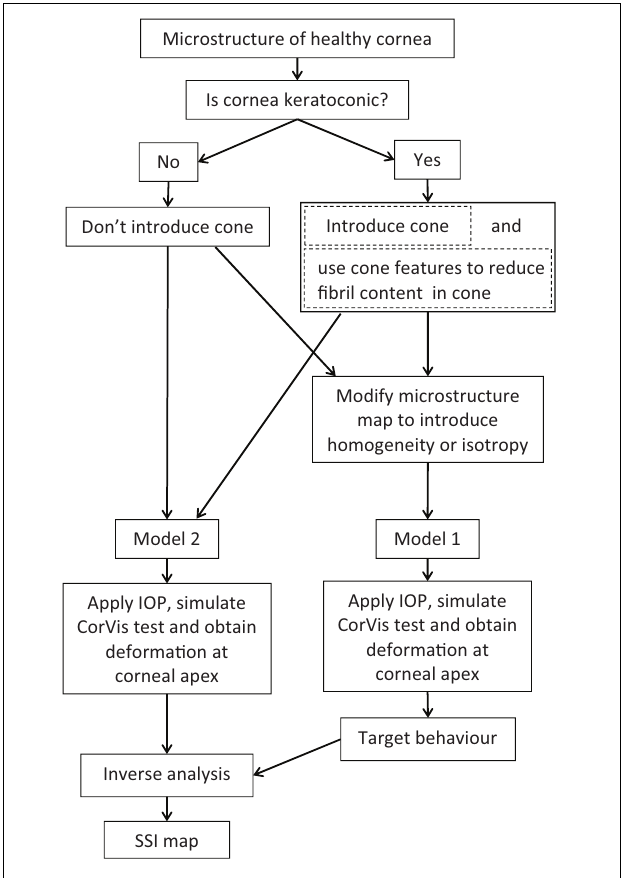
FIGURE 2 | Flow chart of the process adopted to build SSI maps for healthy and keratoconic corneas.